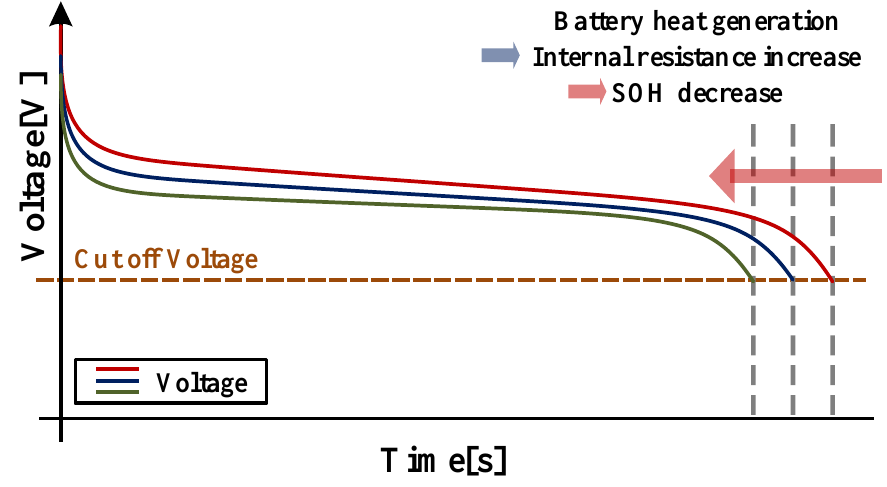
Figure 7. SoH change according to discharging time.